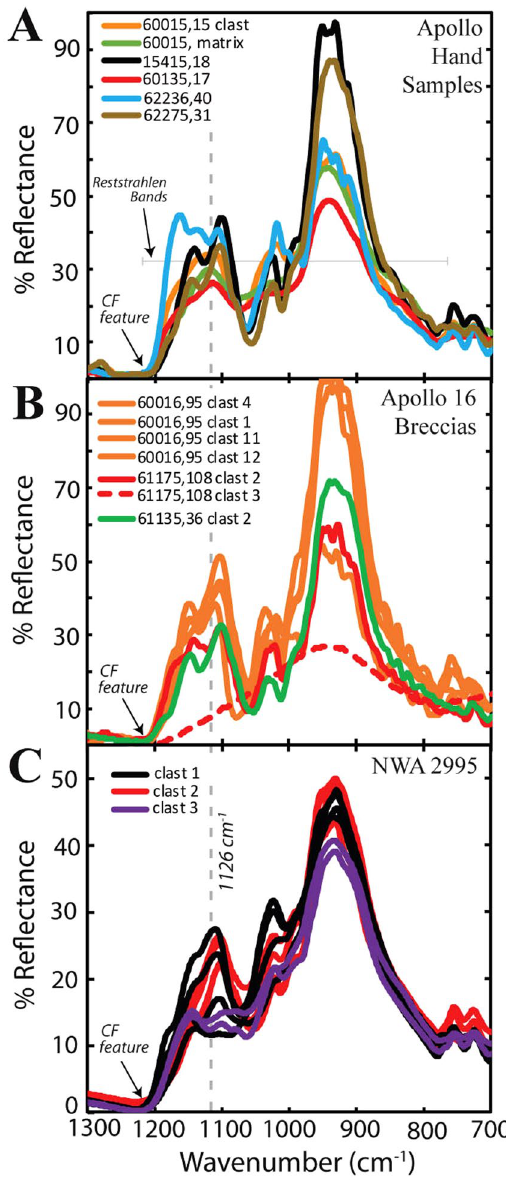
Figure 4. FTIR reflectance spectra (%) for plagioclase within ( A ) FAN hand-samples, ( B ) FAN clasts within Apollo 16 Breccias, and C. lunar meteorite NWA 2995. Uncertainties on FTIR measurements based on repeat analyses are smaller than the line